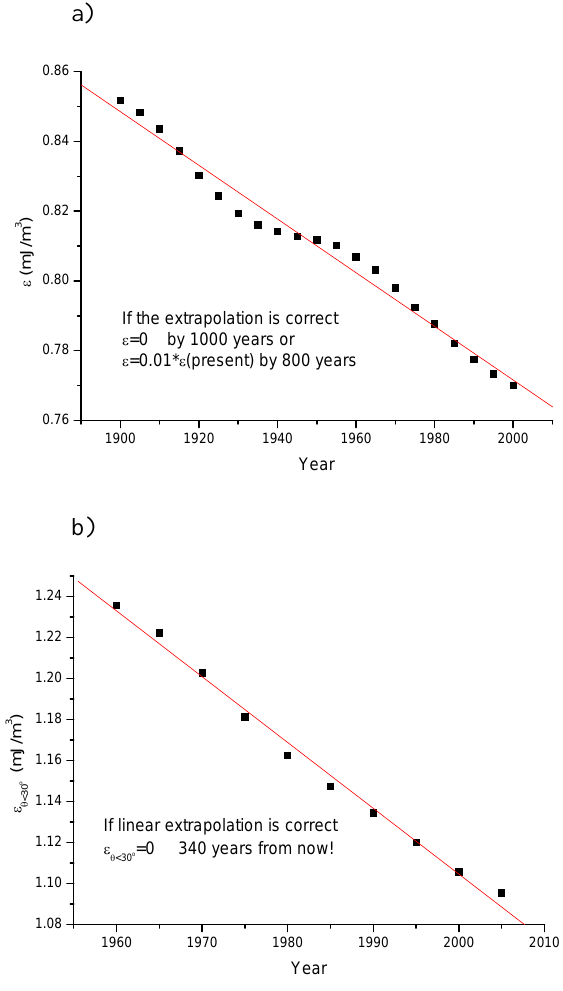
Fig. 2. (a) Global magnetic energy density; (b) Contribution of Antarctica Region to the magnetic energy